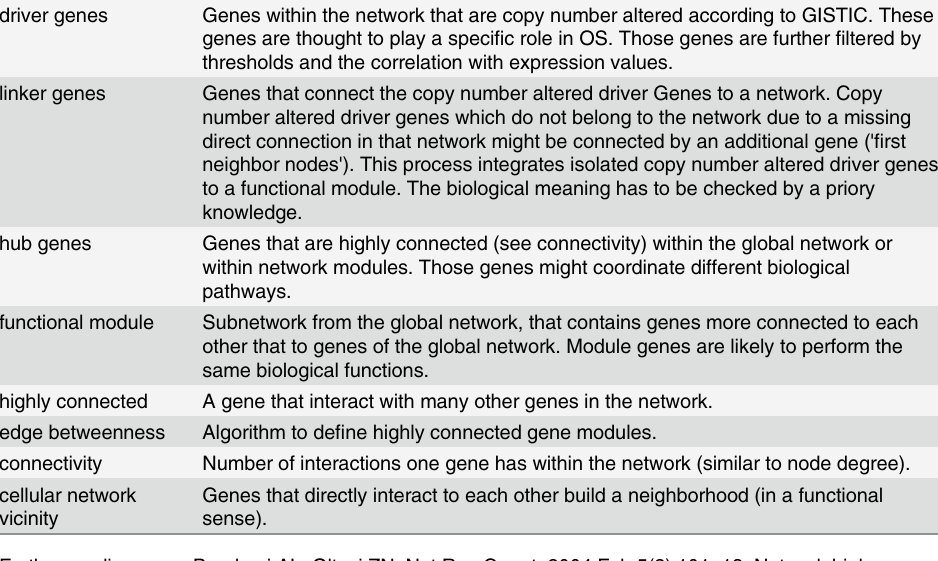
Table 1. Definition of used terms. driver genes